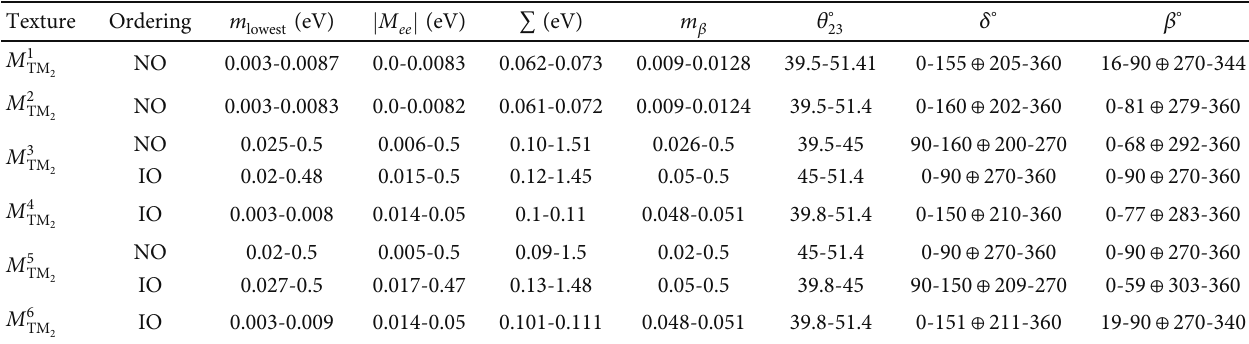
Table 3: Numerical predictions for viable textures having one equality in M